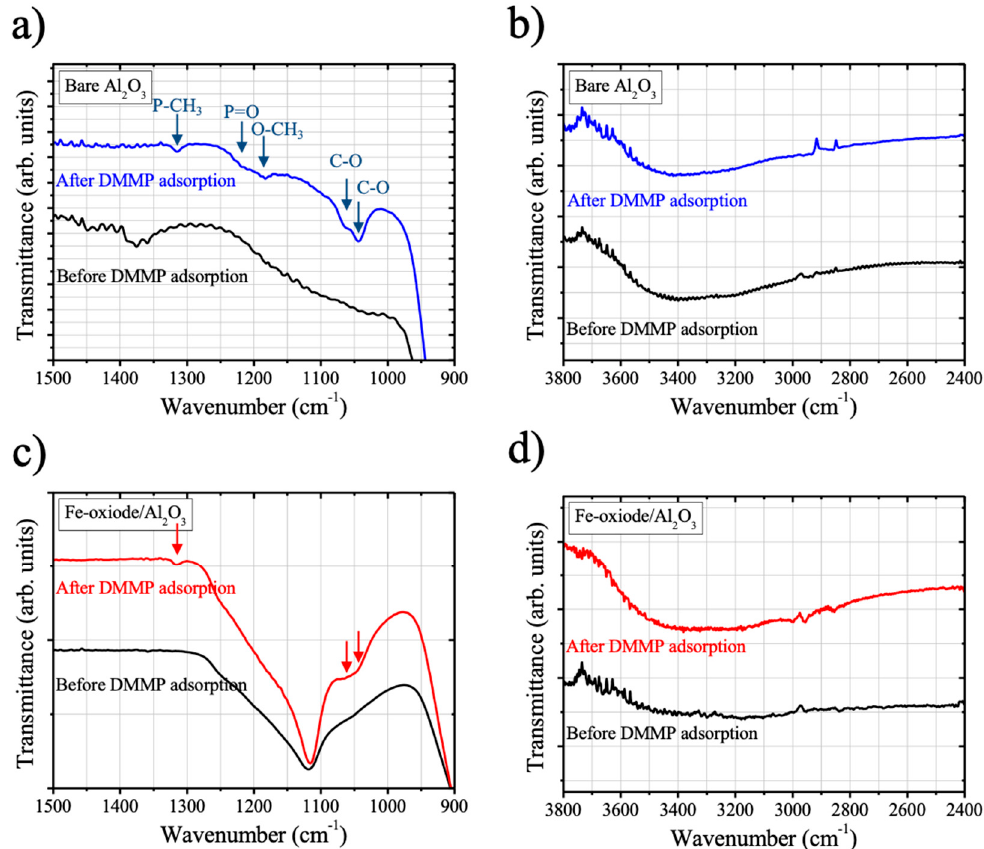
Figure 4. Fourier transform-infrared (FT-IR) spectra of ( a , b ) bare Al 2 O 3 and ( c , d ) Fe-oxide / Al 2 O 3 before and after 360 min of DMMP exposure at room temperature in two di ff erent wavenumber ranges of ( a , c ) 900–1500 cm − 1 , and ( b , d ) 2400–3800 cm − 1 are shown. Characteristic IR absorption peaks of DMMP molecules are marked by arrows in ( a ) and ( c ).